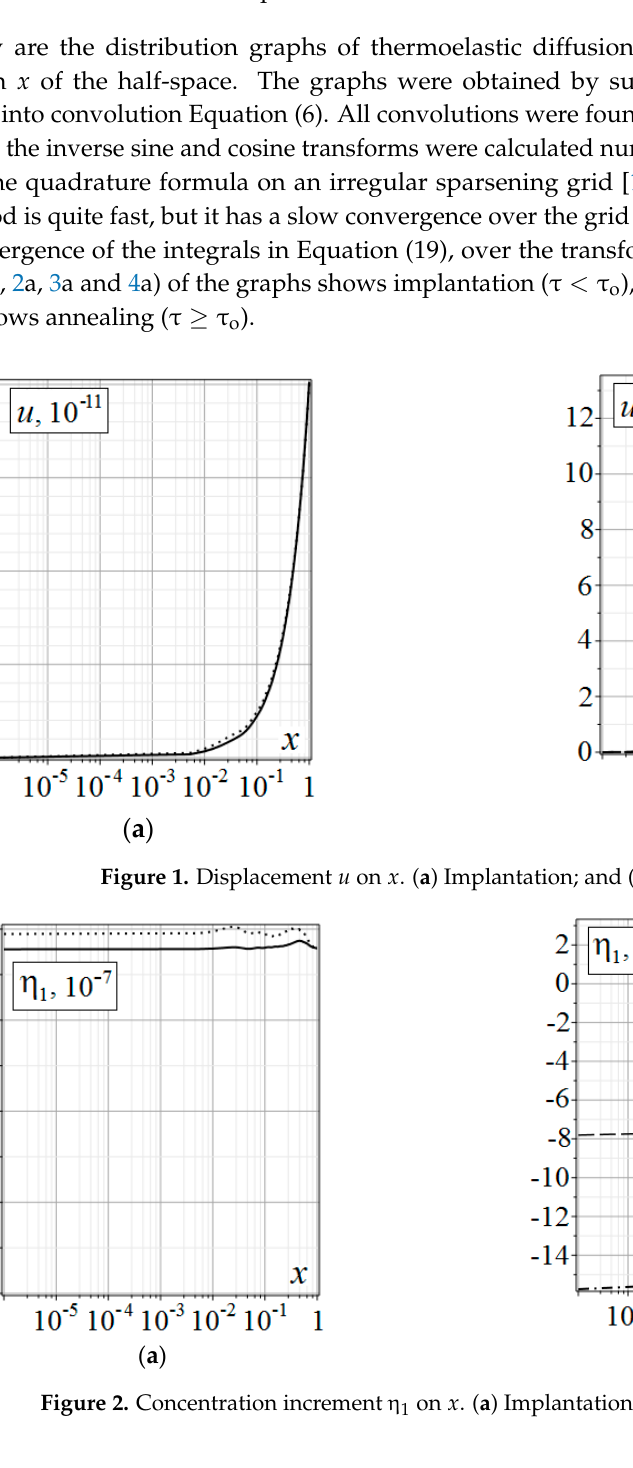
( a ) ( b ) Figure 3. Concentration increment 2 η on x . ( a ) Implantation; and ( b ) annealing. ( a ) ( b ) Figure 4. Temperature increment ϑ on x . ( a ) Implantation; and ( b ) annealing.